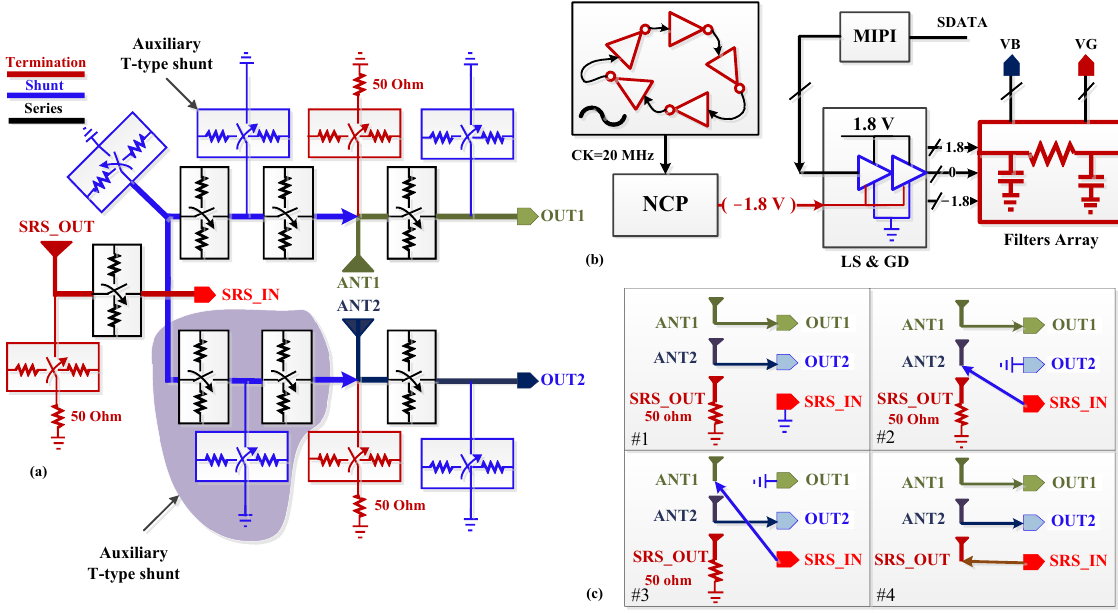
Figure 3. Top block diagram of the 3P3T ( a ) switches configuration, ( b ) analog part, and ( c ) switch- ing cases. ing